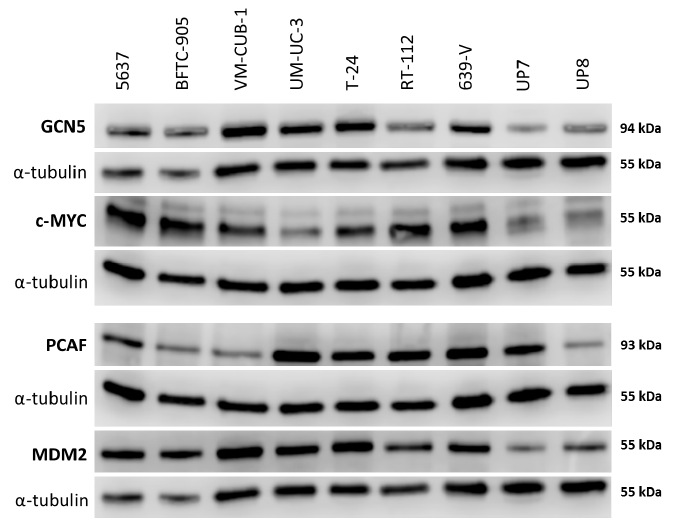
Figure 2. Protein levels of GCN5 and PCAF in cancer cell lines and normal cells. Western blot analysis of PCAF and GCN5 expression in the indicated urothelial carcinoma (UC) cell lines and two normal urothelial cell cultures (UP7, UP8). In addition, their potential interactors MDM2 and c-MYC were analyzed, respectively. MDM2 (Mouse Double Minute 2) was detected on the same membrane as GCN5 after stripping; c-MYC was detected on the same membrane as PCAF after stripping. α -Tubulin was used as a loading control once for each membrane and is shown beneath each of the proteins